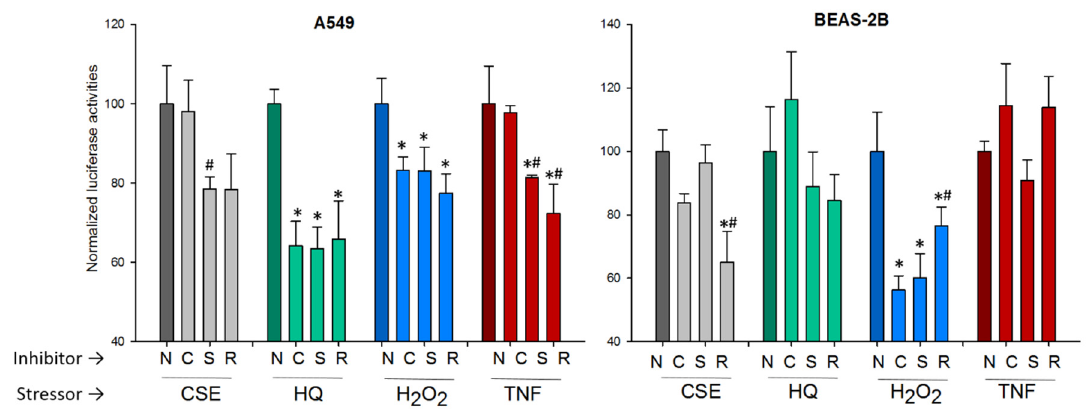
Figure 8. Effects of CMC (C), (4 S )-CMCO (S), and (4 R )-CMCO (R) on activation of the Nrf2 pathway by stressors in A549 and BEAS-2B cells. The luciferase activities in the treated cells are normalized for the reporter activity in wells receiving no inhibitor (N). The stressor concentrations are indicated in Figure 6. The inhibitor concentrations were 1 mM in all experiments. The error bars are SDs; n = 3. The differences of means were probed by the one-way ANOVA; * indicates a statistically significant difference between an inhibitor treatment and “no inhibitor” control; # indicates a statistically significant difference between CMC and CMCO treatments, p < 0.05.